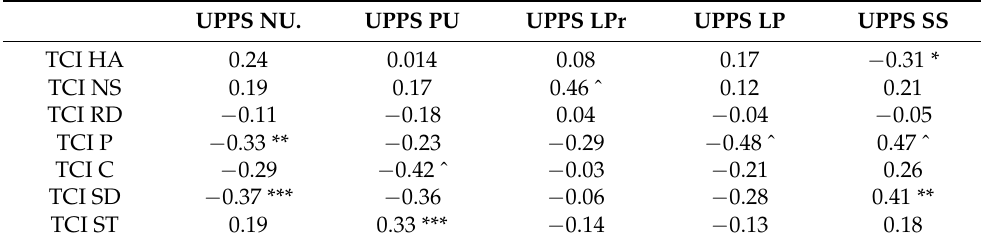
Table 2. Correlation between the TCI-R (56) scales and S-UPPS-P scales. UPPS NU. UPPS PU